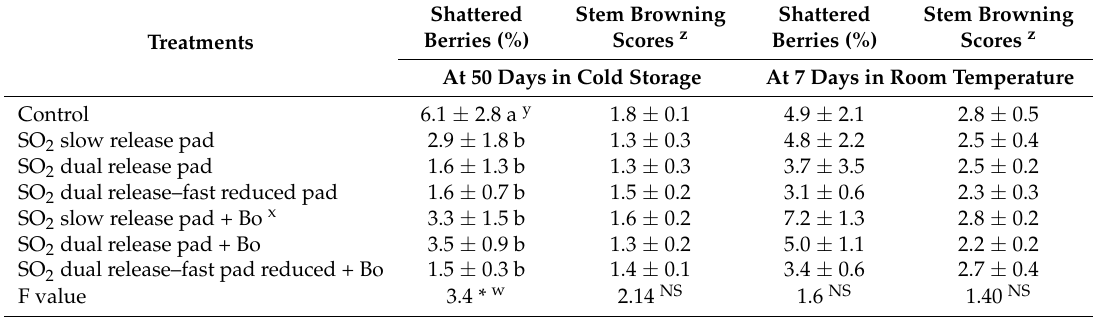
Table 2. Shattered berries (%) and stem browning scores of ‘BRS Vitoria’ seedless table grapes at 50 days in cold storage and 7 days of room temperature under different SO 2 pad treatments.